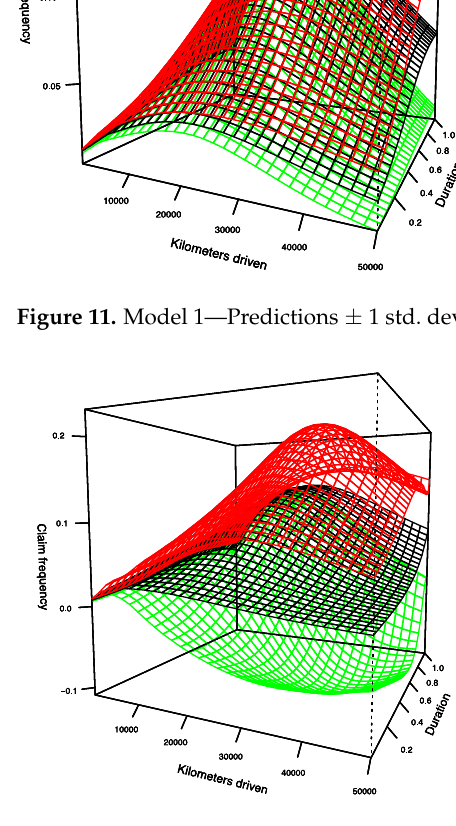
Figure 12. Model 2—Predictions ± 1 std. dev.